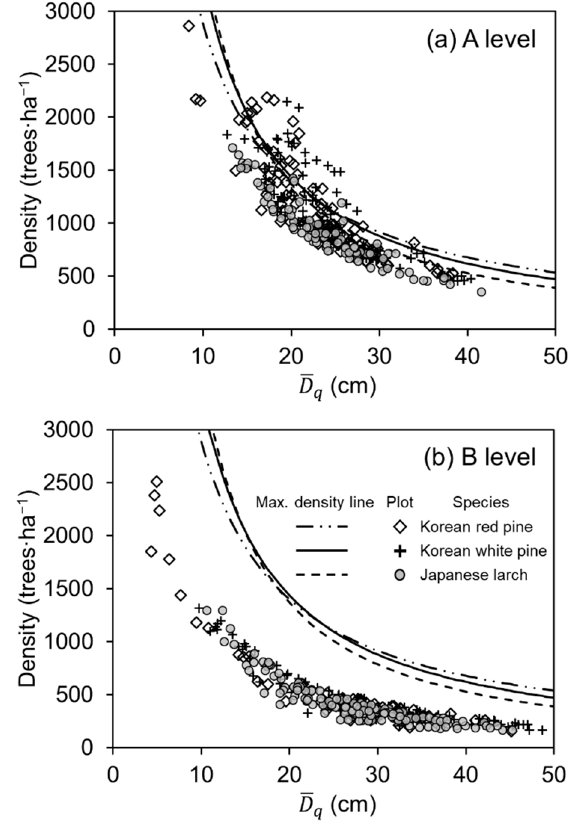
Figure 1. Sample data used to develop ( a ) A-level and ( b ) B-level stocking for Korean red pine, Korean white pine, and Japanese larch with maximum stand density lines by species. Sample data were constrained by plots with relative density > 0.7 for A-level and relative density < 0.5 for B-level. Calculations were made using maximum stand density lines derived from stand density indices in Lee and Choi [27]. D q is the quadratic mean diameter.